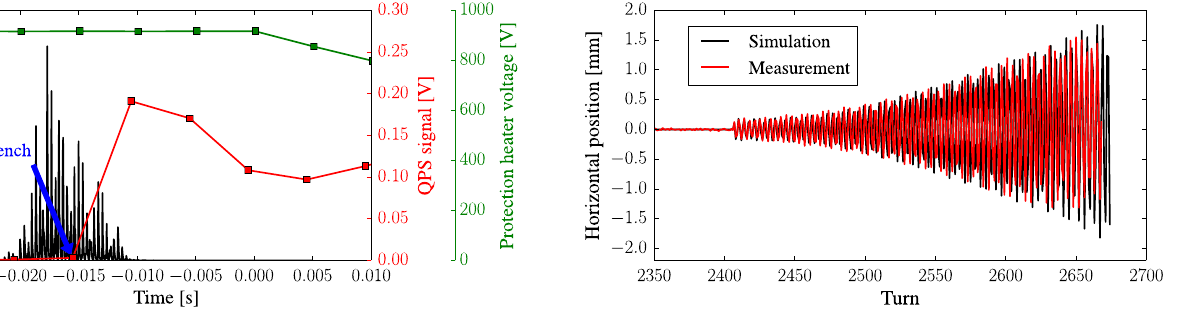
FIG. 12. BLM (black) and QPS (red) signals registered during the orbit-bump quench test with intermediate loss duration. A drop in QPS heater-voltage indicates heater firing (green), which was synchronized with the moment of beam dump. The QPS signal measures resistive voltage in a magnet. The 0.1-V intercept of the QPS signal was timed to precede the heater firing by 10 ms, i.e., the QPS evaluation time.